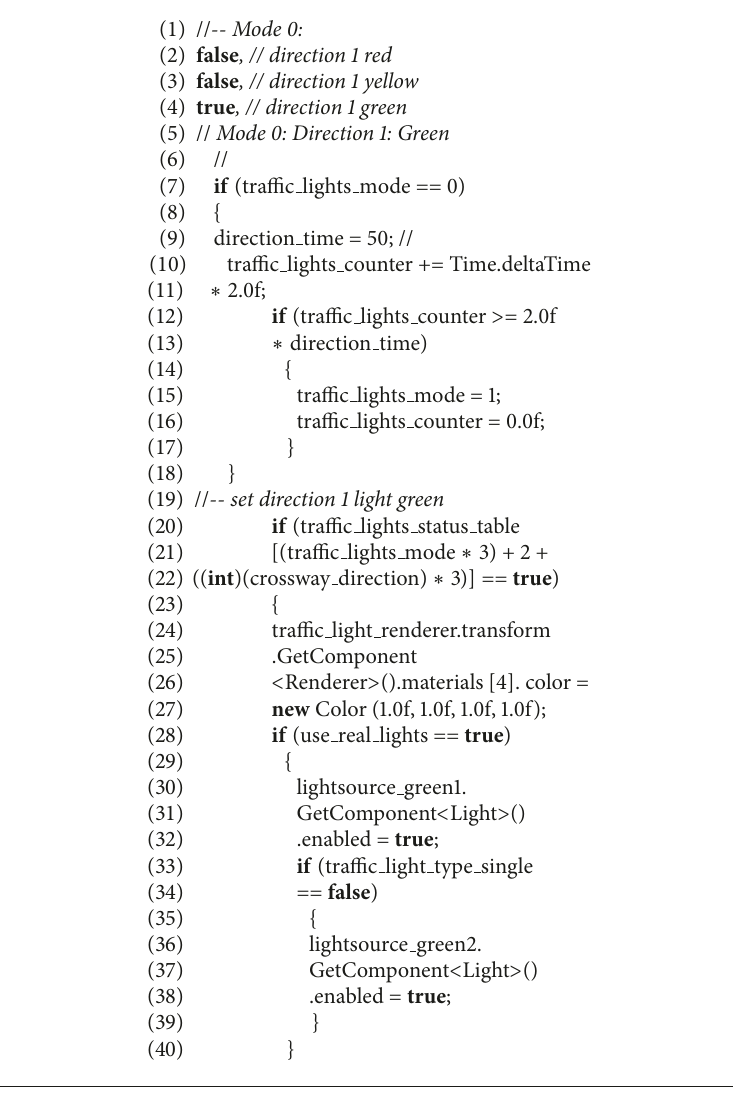
Algorithm 2: Green light